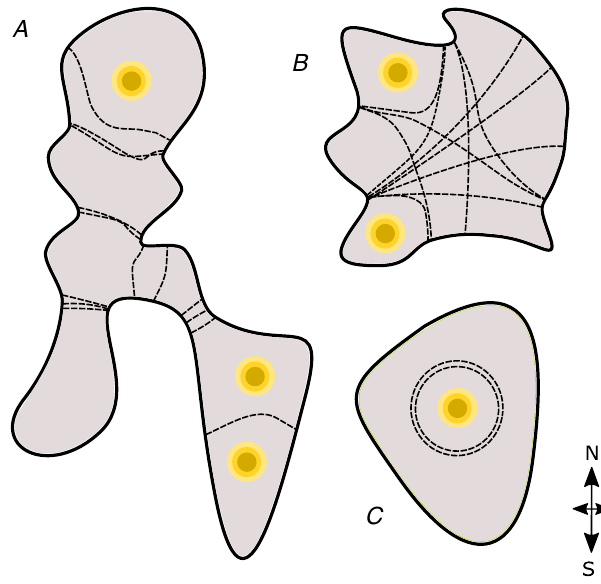
FIG. 19. Schematic diagram of isoglosses (dashed lines) for three language areas or “ island nations. ” Yellow and ochre circles represent cities. Nation A supports dialect areas formed by coastal boundary shape and repulsion from cities. Nation B largely exhibits a continuum of variation apart from two somewhat indistinct city dialects. Nation C has a single city dialect, but without this city (or if the city were not sufficiently densely populated) it would have no linguistic variation due to its entirely convex boundary and evenly distributed